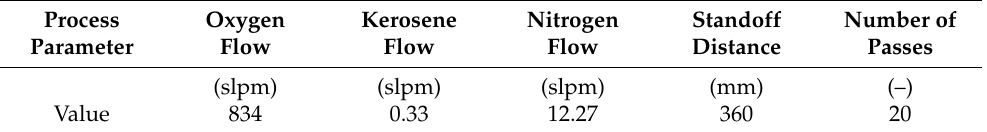
Table 3. High-velocity oxygen fuel (HVOF) process parameters employed to deposit the high entropy alloys